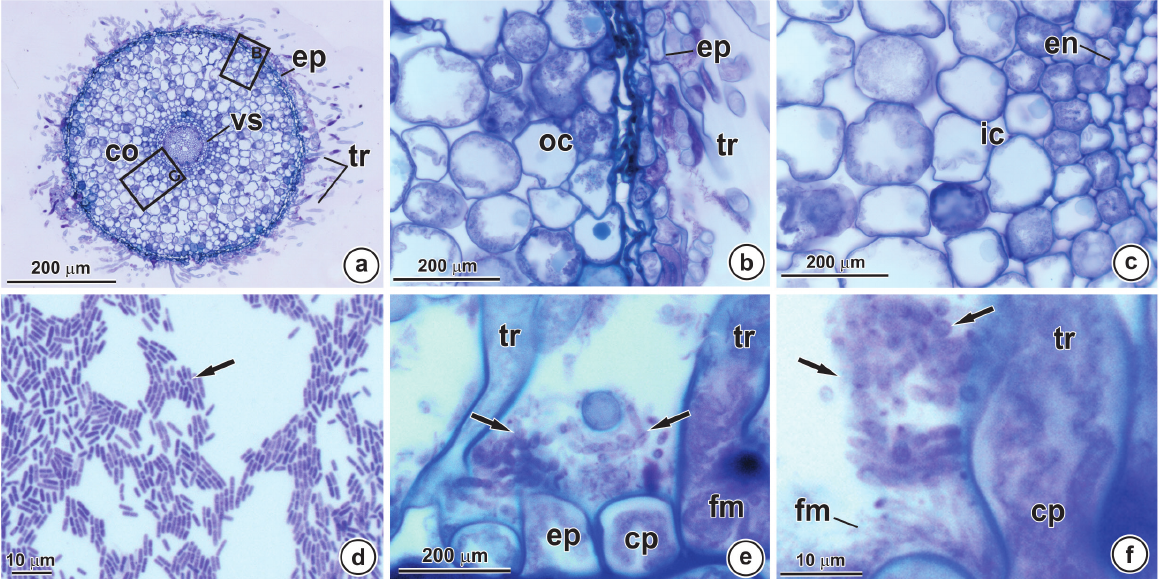
Figure 2 - Musa acuminata root (‘Prata-Anã’ AAB) cultivated in vitro and colonized by the isolate EB-40 ( Bacillus sp.). Cross section of the median region. ( a ) Overview. ( b ) Detail of box B, marked in a. Unicellular, elongated root hairs with lignified walls. Biserial, pavimentous epidermis, with lignified walls. Outer layers of the cortex with small, bulky cells. Retracted protoplast. ( c ) Detail of box C, marked in a. Region of the aerenchymatous internal cortex. Endoderm with cells of suberized walls in all its extension. ( d ) Rod-shaped Bacillus sp. isolate EB-40 cells joined in rows of two to three cells. ( e-f ) A mucilaginous, fibrillar material in the rhizoplane and inside the root hairs. Caption: co: cortex; cp: cytoplasm; en: endoderm; ep: epidermis; fm: fibrillar material; ic: internal cortex; oc: outer cortex; tr: trichome; vs: vascular system. The arrows indicate the location of the